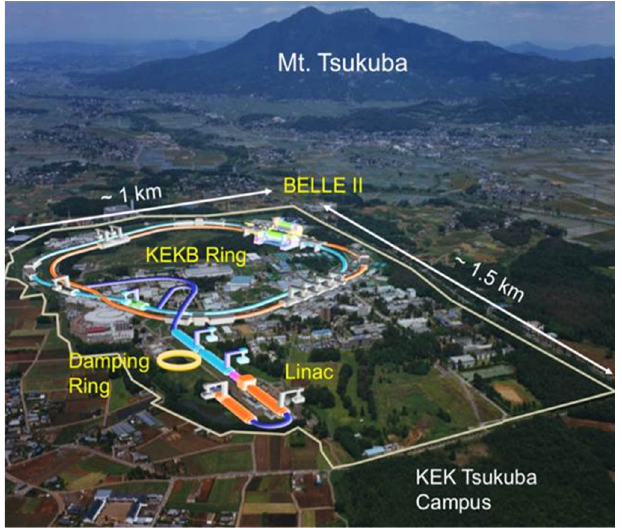
FIG. 1. Layout of SuperKEKB at the KEK Tsukuba